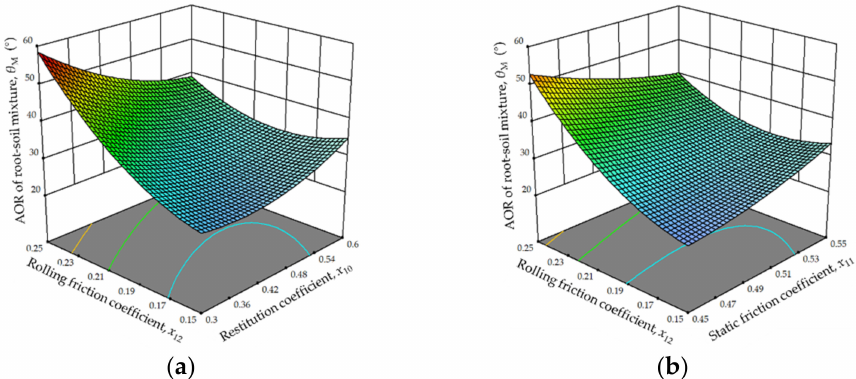
Figure 12. Effects of interaction on the AOR of MRSM: ( a ) the interactive effects of the rolling friction coefficient and restitution coefficient of root-soil; and ( b ) the interactive effects of the rolling friction coefficient and static friction coefficient of